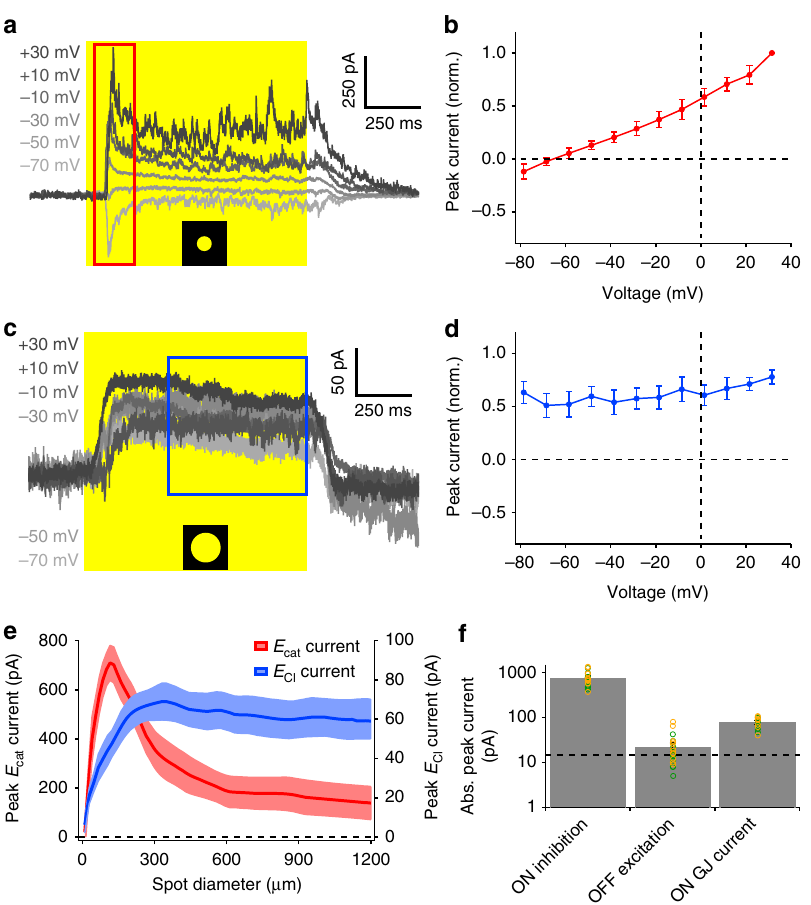
Fig. 4 Synaptic inputs to OFF OS RGCs. a Current evoked in an OFF OS RGC by a light step (200 μ m diameter) from darkness measured across a range of holding voltages. Yellow rectangle indicates light stimulus. b IV relationship for the stimulus in a . Error bars indicate SEM across n = 13 cells. Peak currents were measured in the temporal window (0 – 200 ms) indicated by red rectangle in a . c Current evoked in an OFF OS RGC by a light step (1200 μ m diameter) from darkness measured across a range of holding voltages. Yellow rectangle indicates light stimulus. d IV relationship for the stimulus in c . Error bars indicate SEM across n = 13 cells. Peak currents were measured in the temporal window (500 – 1000ms) indicated by blue rectangle in c . e Peak currents at excitatory reversal potential (red trace) and chloride reversal potential (blue trace) to spots of varying diameters for n = 13 cells. Currents were measured in a 0 – 200 ms temporal window at E cat and 500 – 1000 ms temporal window at E Cl . Shaded regions indicate SEM across cells. f Absolute peak currents evoked by a 200 μ m diameter spot of light in OFF OS RGCs. Dotted line indicates peak baseline noise